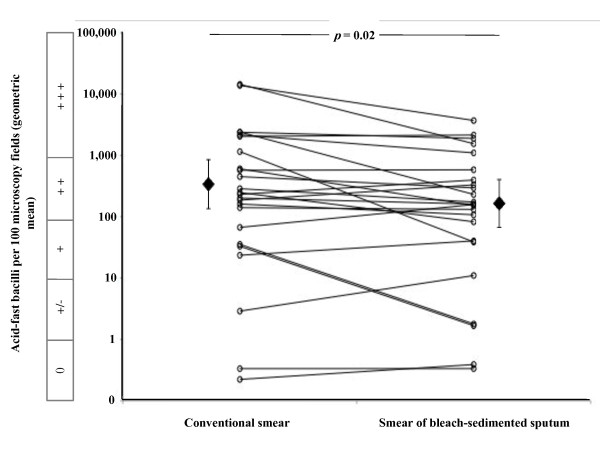
Effect of bleach-sedimentation on the concentration of acid-fast bacilli. The number of acid-fast bacilli visualised by smear-microscopy is shown. Each of the open circles represents the geometric mean number of acid-fast bacilli visible in 100 microscopy fields for triplicate, identically prepared slides. Each line joins the data derived from 1 of the 25 sputum specimens i.e. the geometric mean of triplicate conventional smear-microscopy slides (the left-hand end of each line) versus the geometric mean of triplicate slides prepared after bleach-sedimentation (the right-hand end of each line). The filled diamonds represent the geometric mean of all 25 specimens and the error bars represent 95% confidence intervals. The box parallel with the vertical axis indicates the smear-microscopy grade equivalent to the acid-fast bacilli counts per 100 microscopy fields (0 indicates none visible/100 fields; +/- indicates 1-9/100 fields; + indicates 10-99/100 fields; ++ indicates 100-999/100 fields; and +++ indicates > 1, 000/100 fields).